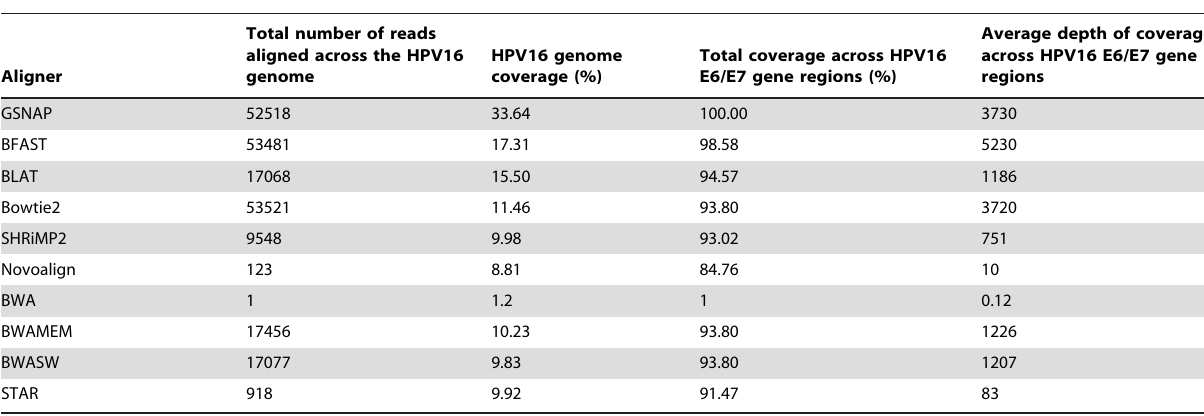
Table 11. Alignment results across the HPV16 and the E6/E7 gene regions.